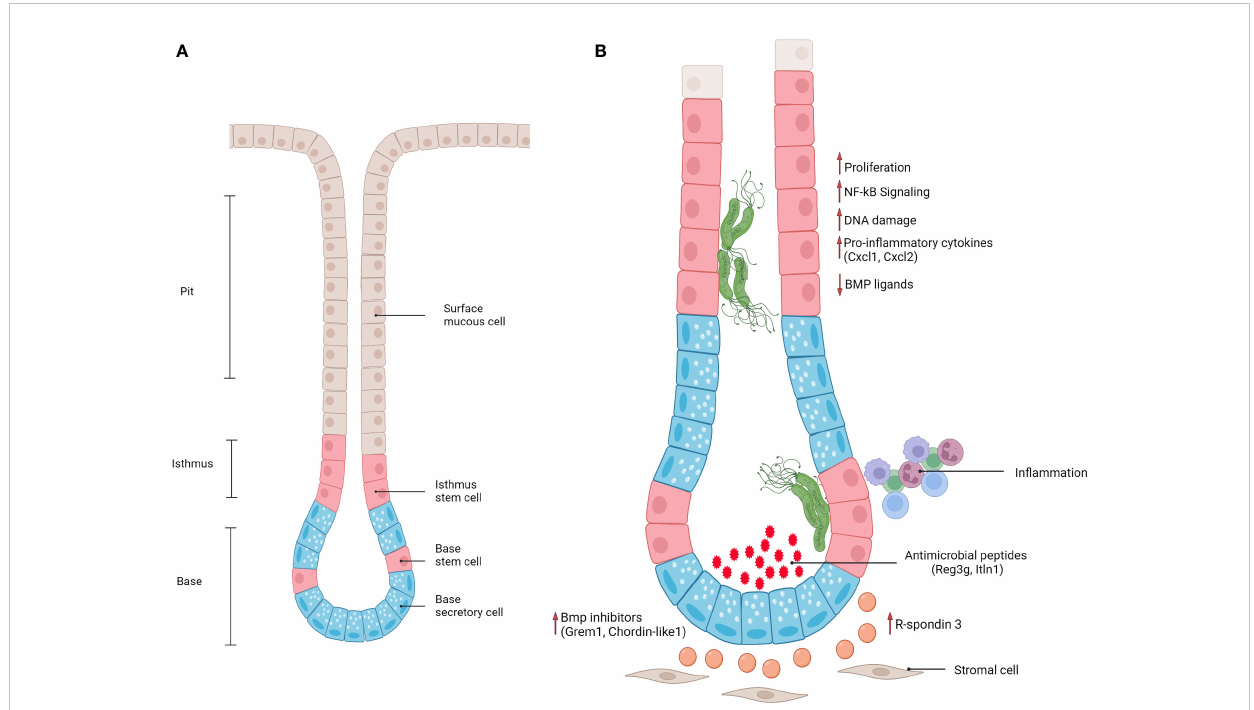
FIGURE 1 (A) Schematic representation of antral gland regions (pit, isthmus, base) and epithelial cell populations. (B) Schematic representation of epithelial and stromal responses in antral gastric glands infected with gland-associated H. pylori